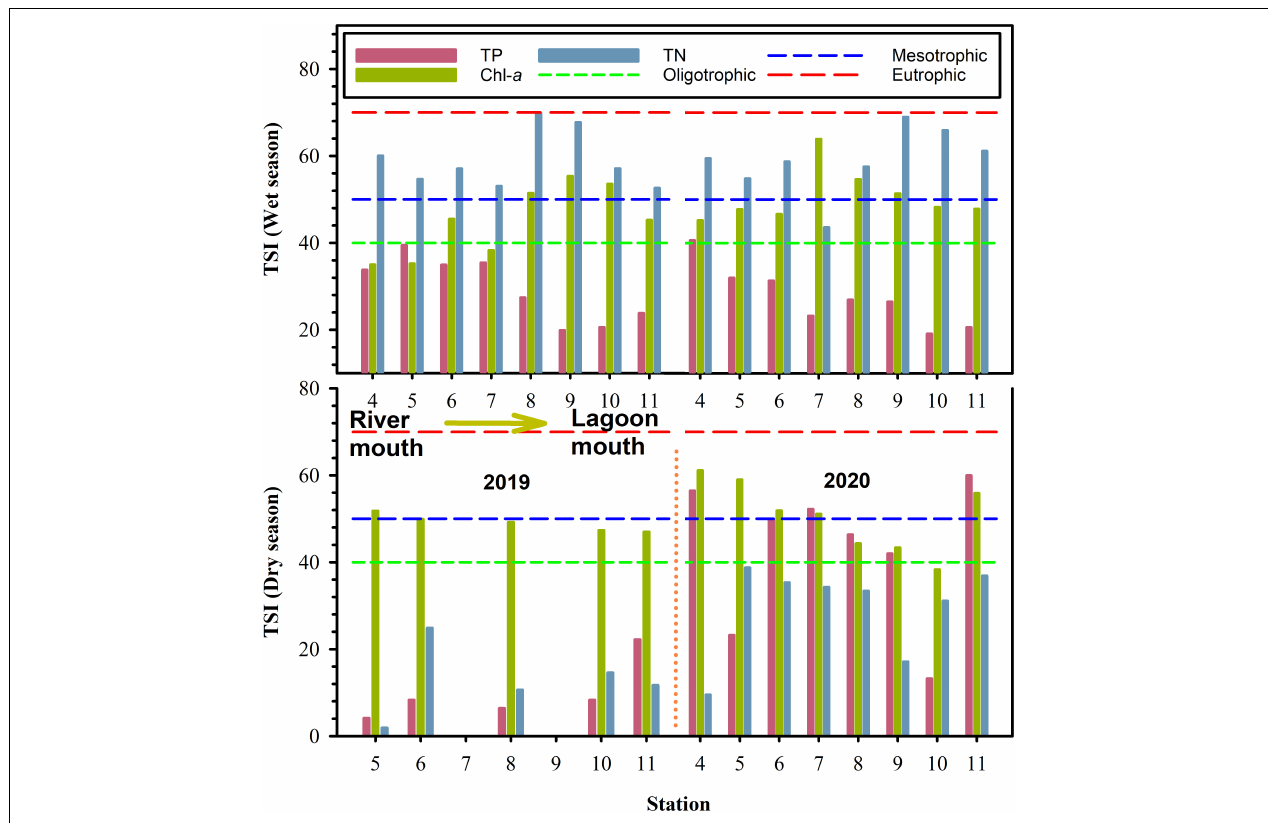
FIGURE 6 | Trophic state index from TP, TN, and Chl- a in dry season and wet season in Negombo lagoon. Short dash line represents oligotrophic, medium dash line represents transition from oligotrophic to mesotrophic, long dash line represents transition from mesotrophic to